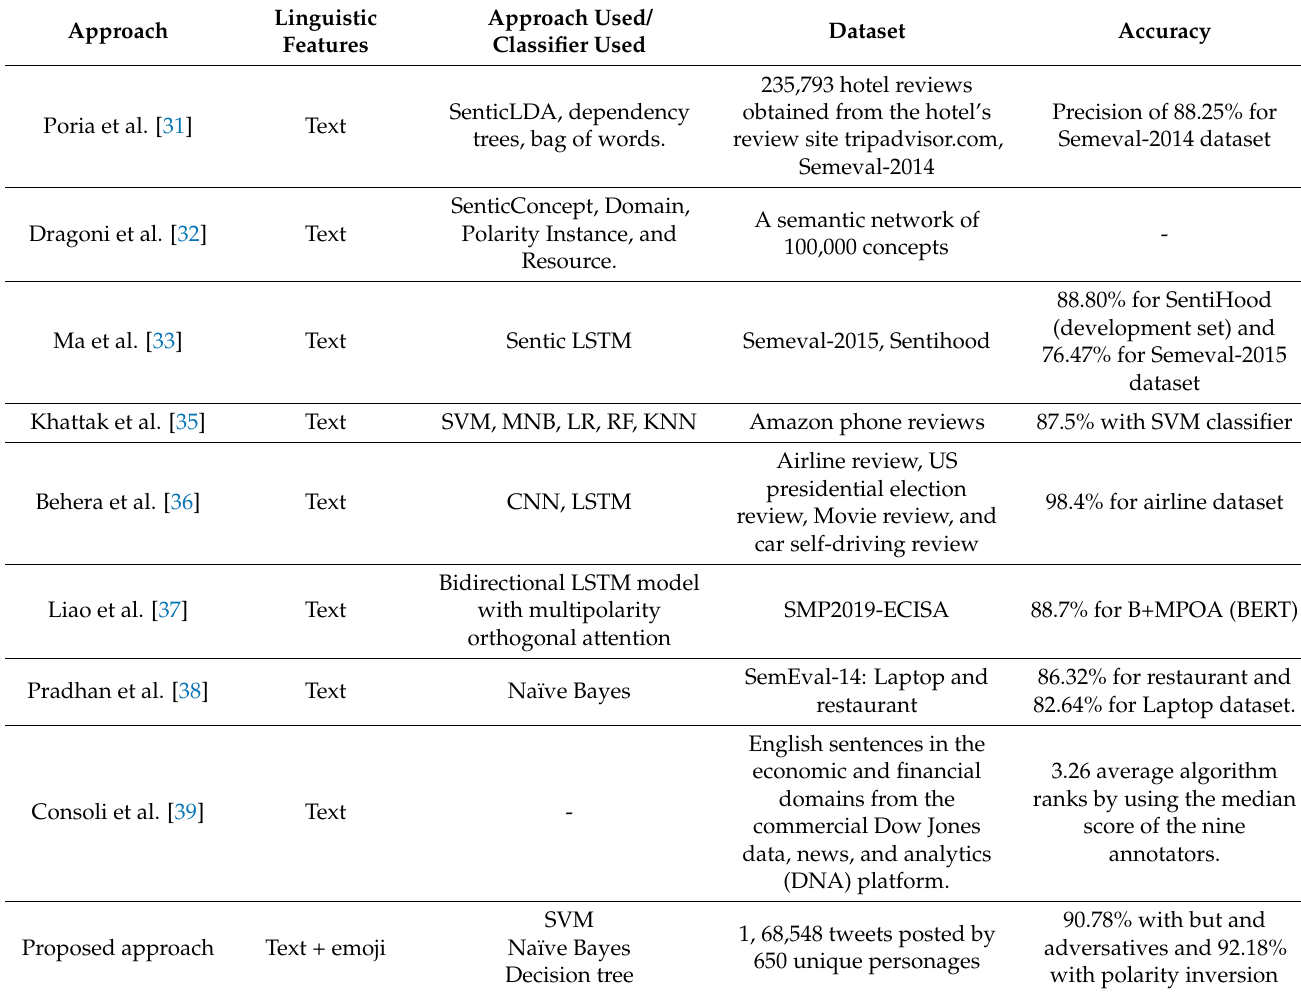
Table 1. Comparative study of state of the art for various sentiment analysis